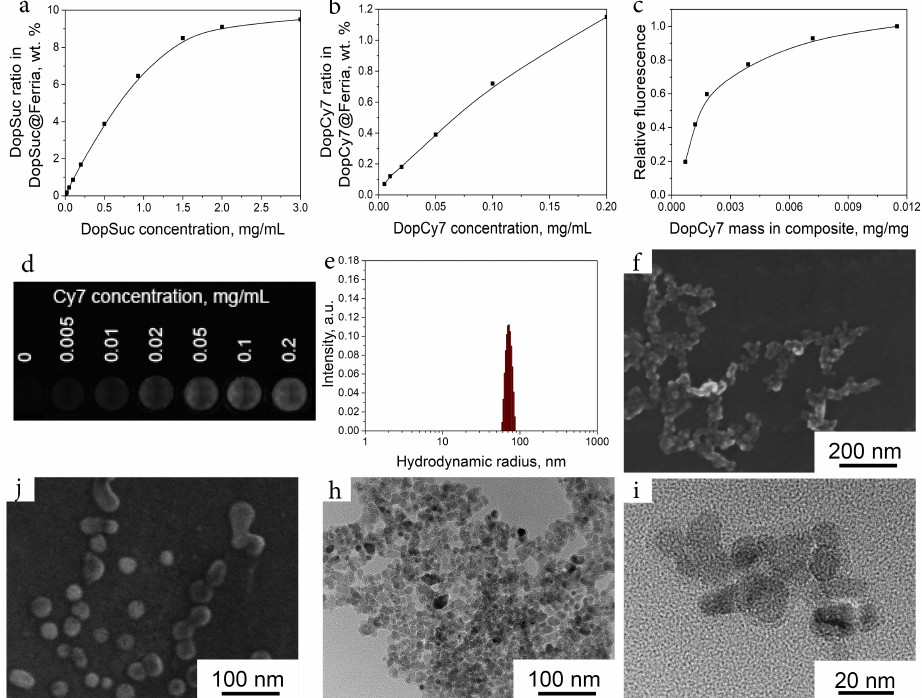
Figure 3. Modification of Ferria with DDs. Mass fraction of the coating in the composite as a function of DopSuc ( a ) or DopCy7 ( b ) concentration in solution; relative fluorescence of the composite as a function of DopCy7 mass fraction in its composition ( c ); visual appearance of the fluorescent composites ( λ ex = 730 nm, λ em = 780 nm) depending on the used concentration of DopCy7 during deposition step ( d ); the hydrodynamic radius of the composite measured by DLS technique ( e ); SEM images of the composite ( f , j ); TEM images of the material ( i , h